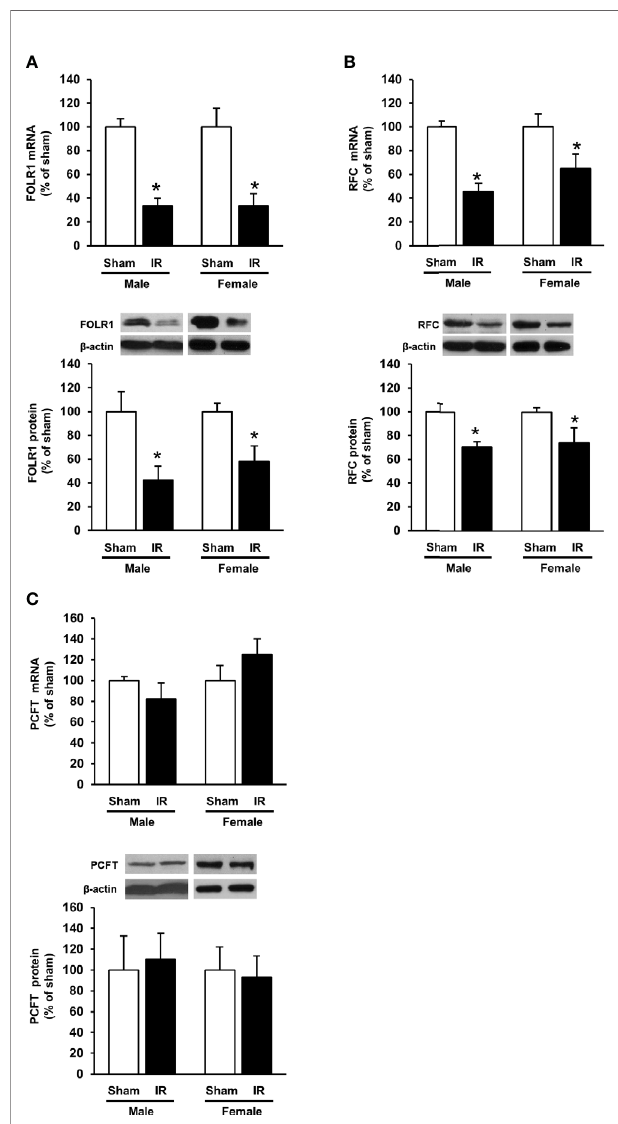
FIGURE 3 | Expression offolate transporters in rat kidneys. Rats were subjected to kidney ischemia-reperfusion (IR) or sham operation (sham). The mRNA and protein of (A) folate receptor 1 (FOLR1), (B) reduced folate carrier (RFC) and (C) proton-coupled folate transporter (PCFT) in the kidneys of male and female rats were determined by real-time PCR and Western immunoblotting analysis, respectively. Results are expressed as mean ± SE (n = 6). * P < 0.05 when compared with the value obtained from the sham-operated